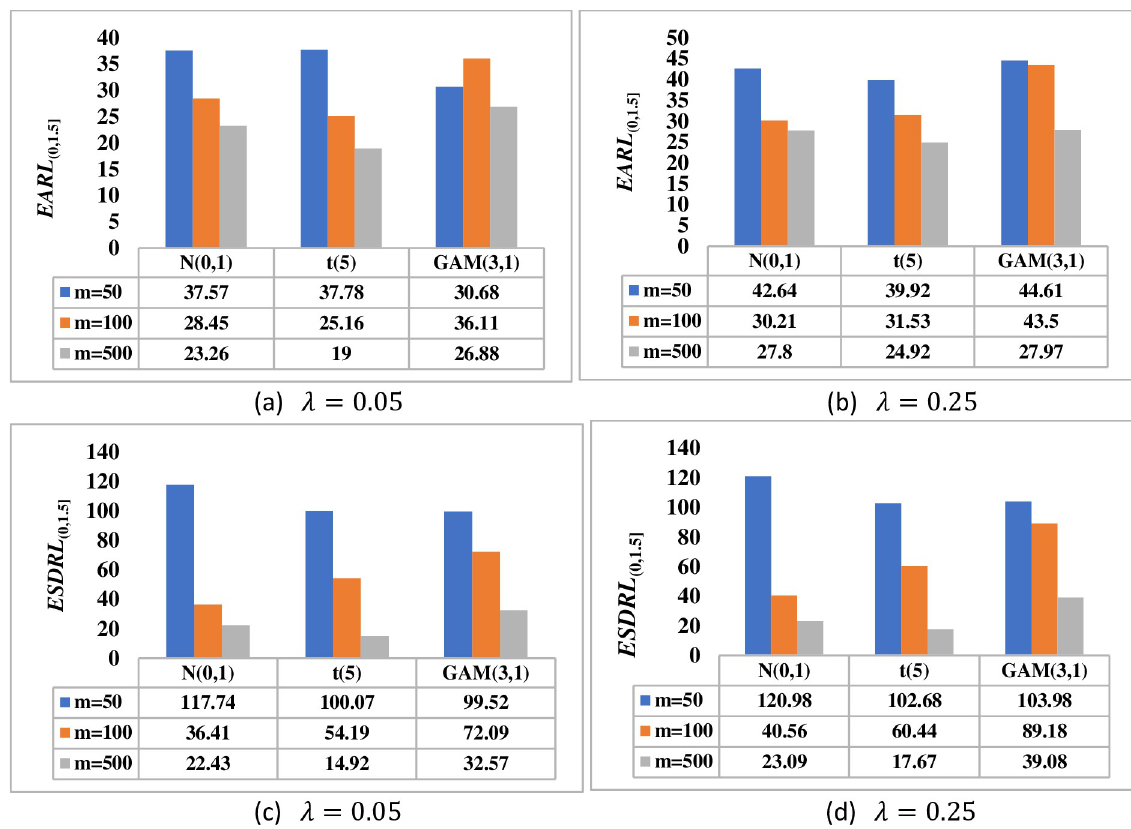
Fig 4. Effect of the phase I sample size on the performance of DHWMA W scheme when n = 5, λ 2 {0.05, 0.25} and m 2 {50, 100,500} under N (0,1), t (5) and GAM (3,1)